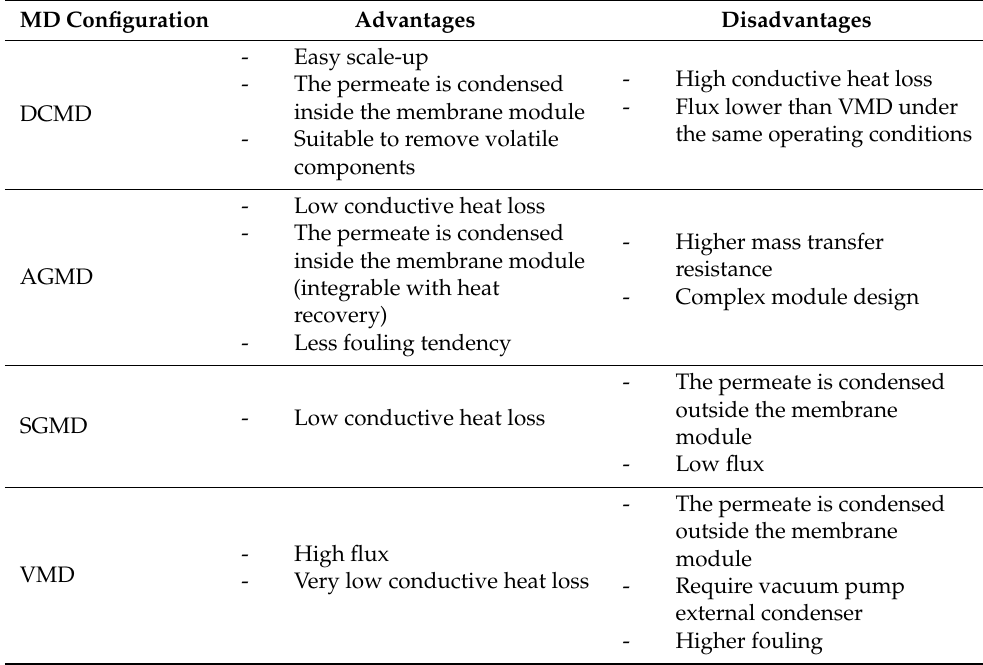
Table 1. Advantages and disadvantages of basic MD